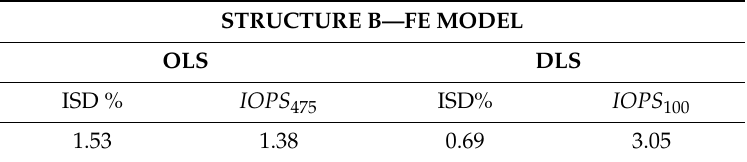
Table 15. Maximum Interstory Drift (ISD) % and operativity indicators IOPS 475 and IOPS 100 for OLS and